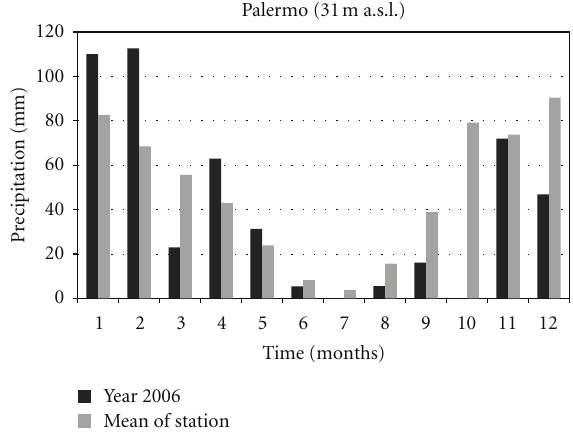
Figure 5: Monthly rainfall trend in 2001 compared with the mean trend registered in the thermopluviometric